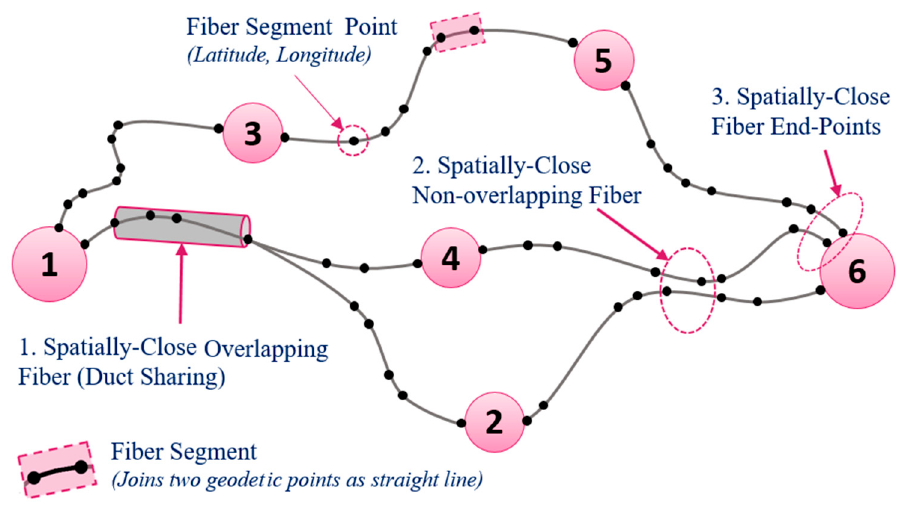
Figure 7. Link Representation and their Minimum Separation Distance.